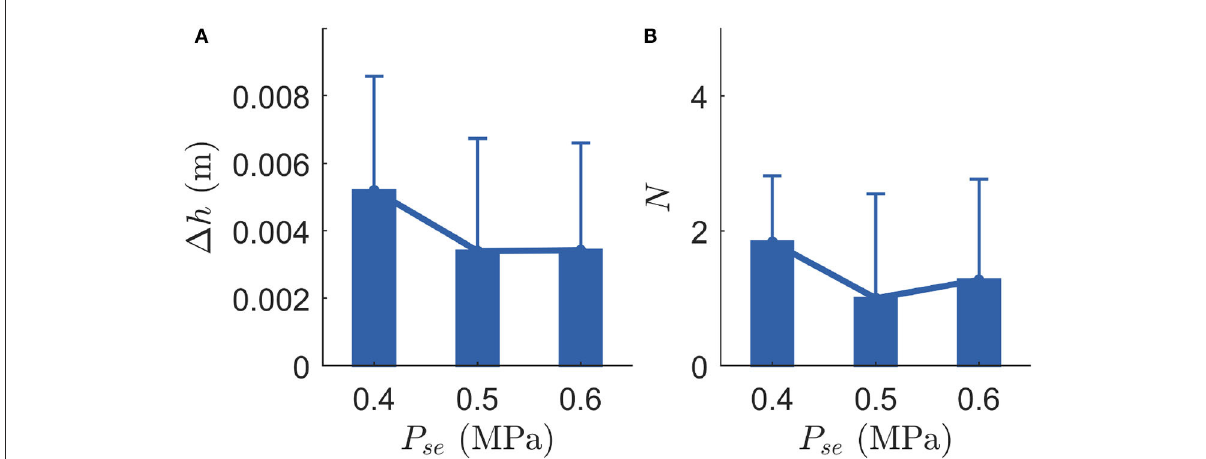
FIGURE7 Experiment results on EPA-Hopper II. Each experimental condition was repeated six times. P se indicates the serial PAM pressure. Error bars indicate one SD. (A) Stable hopping height difference ( 1 h , hopping stability). (B) The number of hops required to recover from the perturbation ( N , hopping